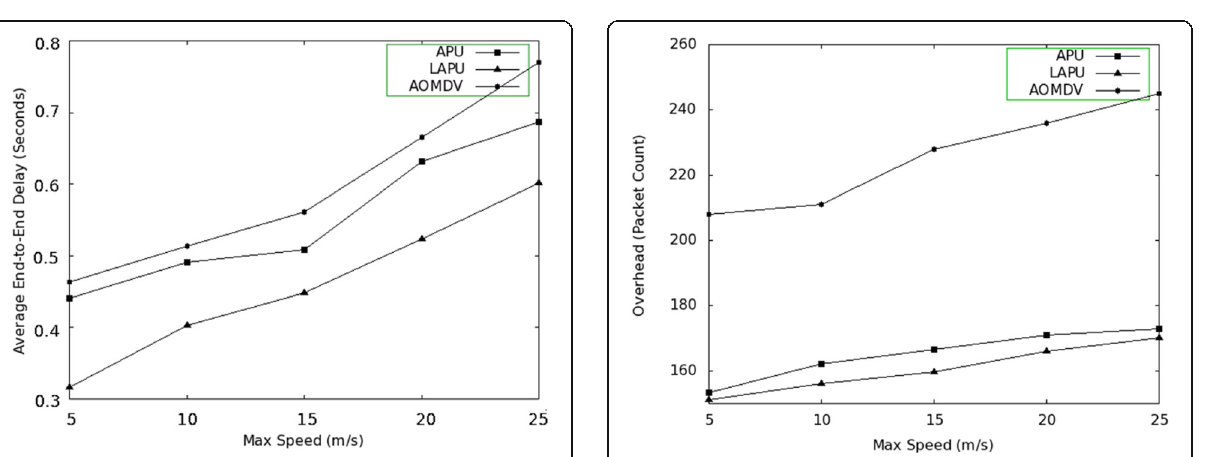
Fig. 7 Routing overhead vs. node mobility